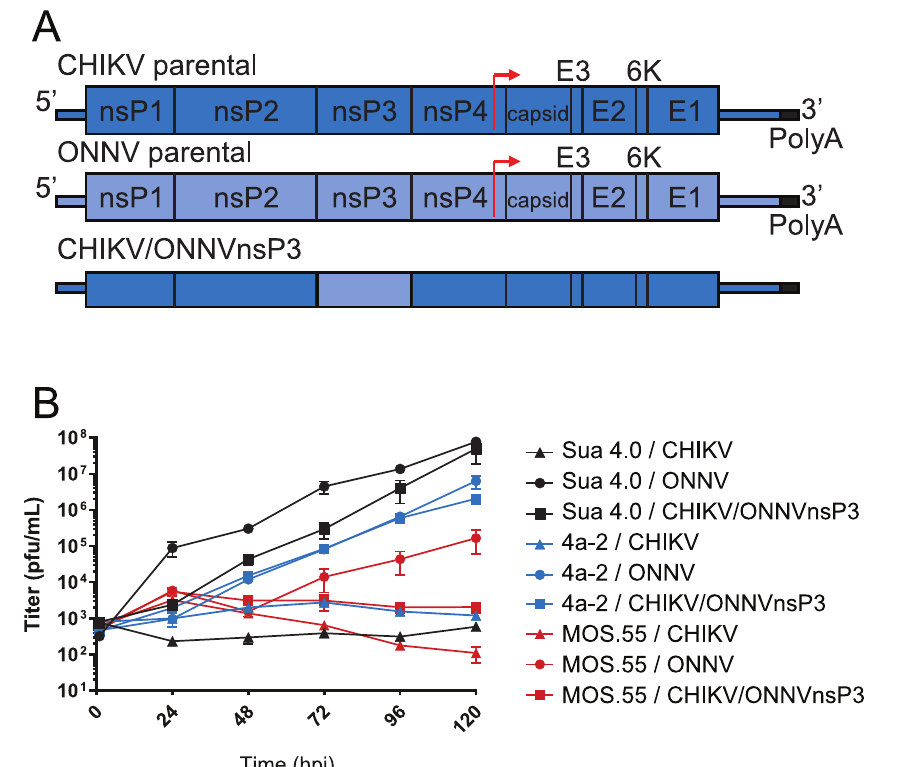
Fig 1. Anopheles cell lines infected with CHIKV, ONNV, and CHIKV/ONNVnsP3. (A) Viruses used in this study. The structures of CHIKV, ONNV, and recombinant CHIKV/ONNVnsP3 that has a CHIKV backbone with the nsP3 from ONNV are shown. Adapted from [11]. (B) Growth curves of the above viruses (MOI = 0.1) in three anopheline cell lines; Sua 4.0, 4a-2, and MOS.55. Experiment was performed in triplicate with titers assayed in duplicate for each replicate. The mean and standard error are